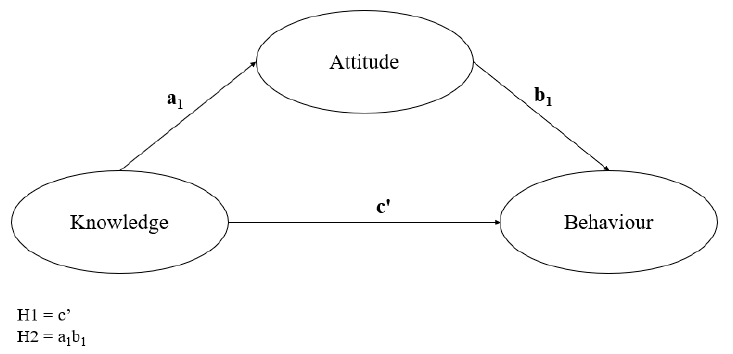
Figure 1. Structural model.